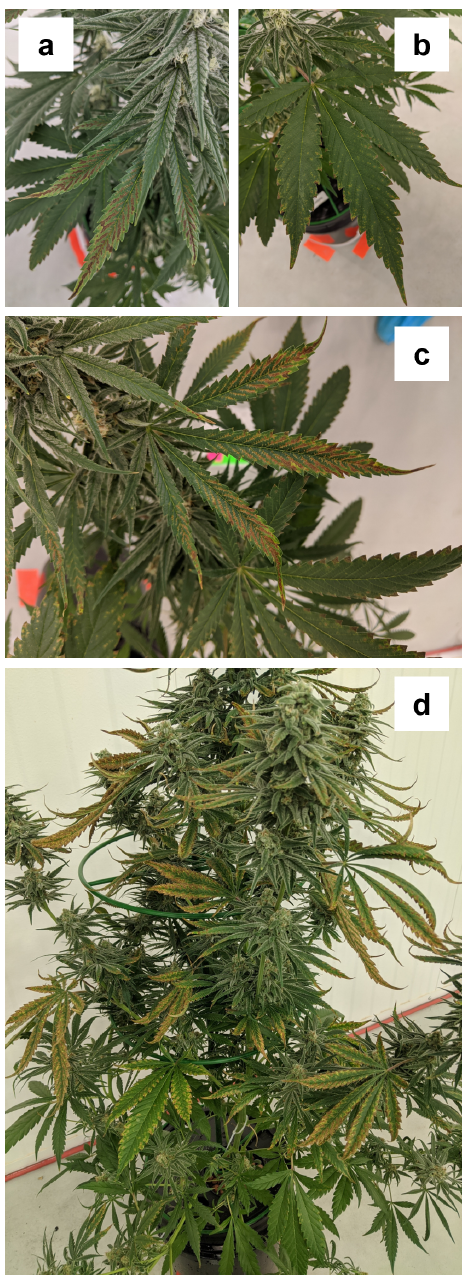
Figure 4. Progression of potassium (K) deficiency on ( a ) sugar, and ( b ) fan leaves on week four and in the middle of the canopy in week five ( c , d